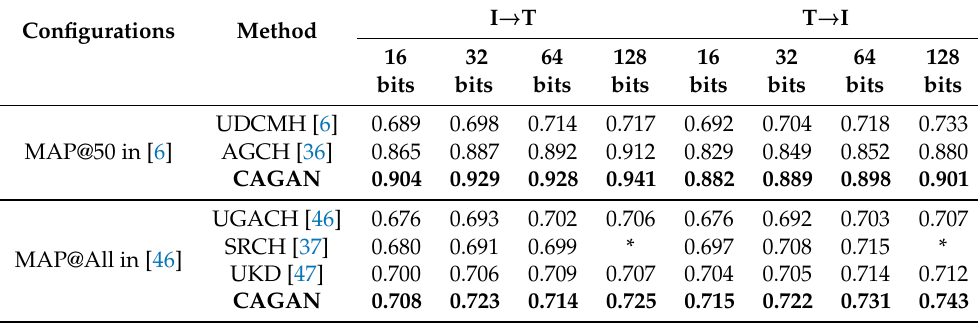
Table 3. The MAP comparison results with extra methods on the MIRFLICKR-25K dataset. Configurations